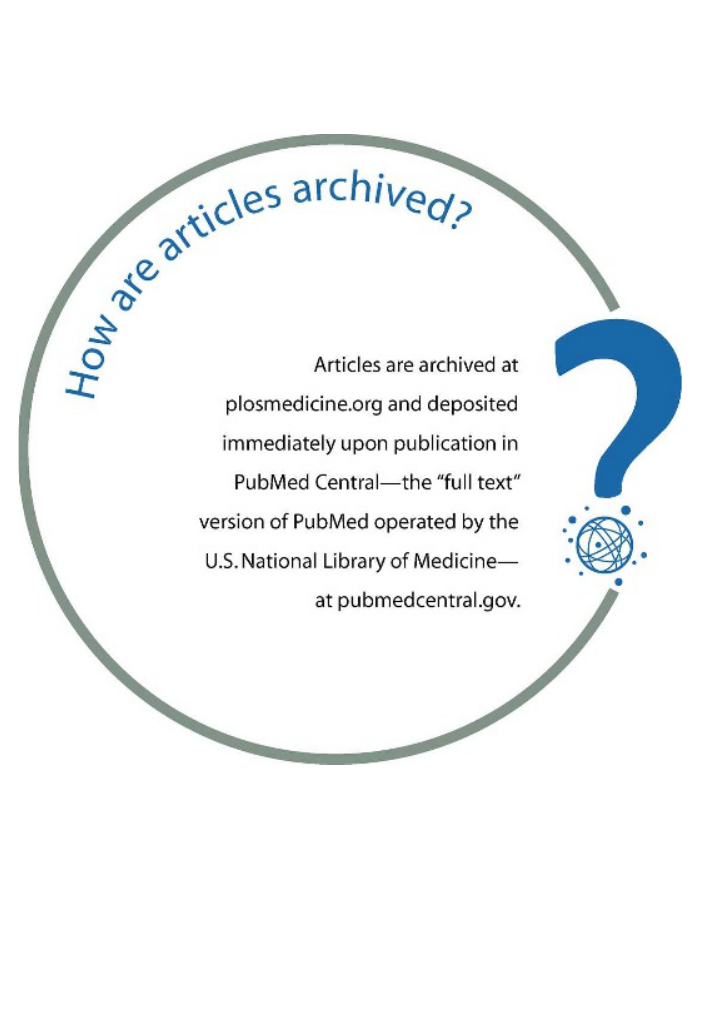
Table S1. Competing Interests Policies: Questions for Editors to Consider Found at DOI: 10.1371/journal. pmed.0020088.st001 (33 KB DOC). Table S2. Members of the PLoS